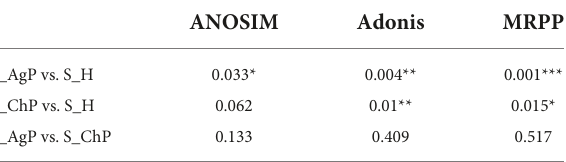
TABLE 2 Differences in microbial community structure among the three groups ( p- value).